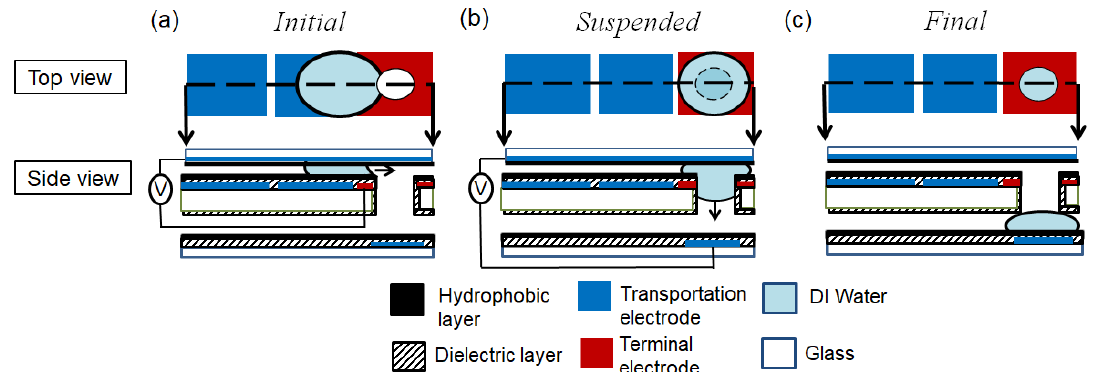
Figure 2. The droplet passes through (or inserts into) the orifice. There are three stages: ( a ) initial stage, when the droplet is transported to the terminal electrode by EWOD actuation; ( b ) suspended stage, when the droplet is inserted into the orifice at the terminal electrode; and ( c ) final stage, when the droplet is detached and vertically moves towards the elec- trode.